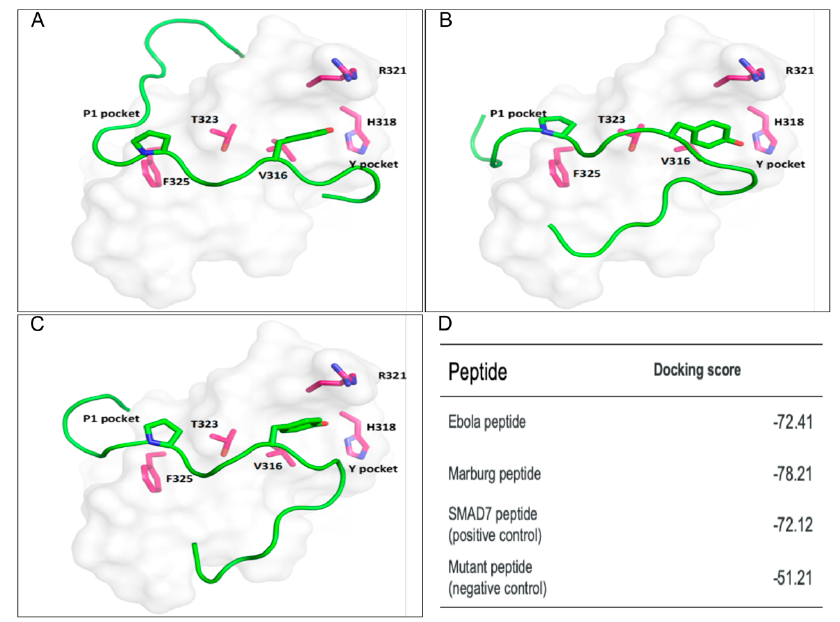
Figure 2. Docking Models of PPxY/WW interactions. Docking models showing PPxY/WW interactions for: ( A ) eVP40-WT, ( B ) mVP40-WT, and ( C ) SMAD7 PPxY-containing peptides with WW domain #3 from SMURF2. ( D ) Protein–peptide docking scores.